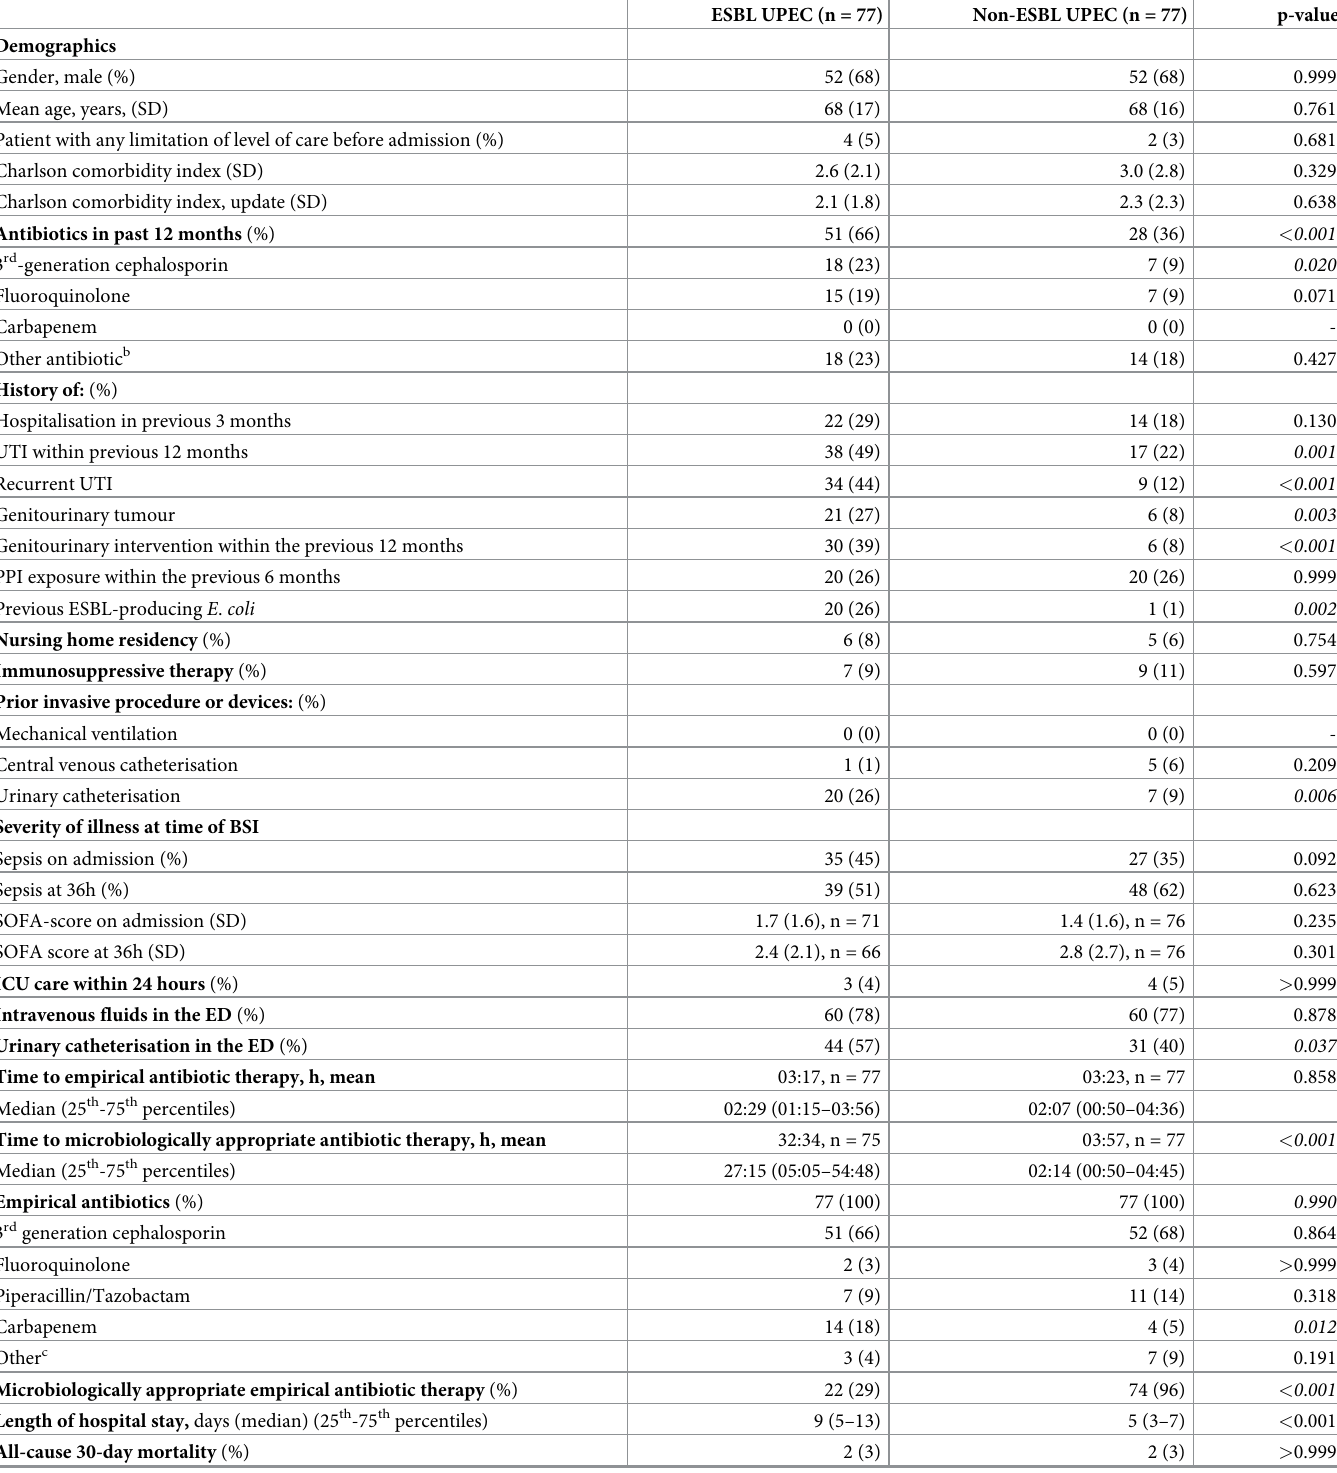
Table 1. Demographics and baseline characteristics of patients with uropathogenic Escherichia coli (UPEC) bloodstream infection a